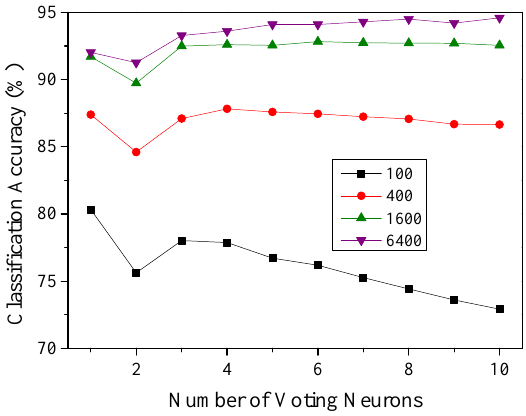
Figure 6. Impact of the number of voting neurons on classification